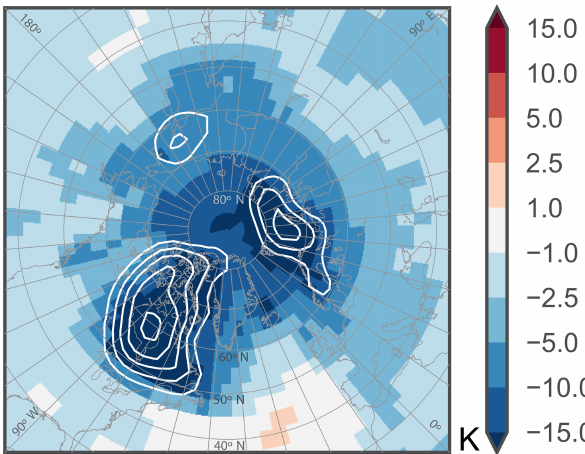
Figure 3. Temperature difference between the pre-surge phase and a preindustrial experiment, overlay: topography increase from preindustrial to pre-surge glacial state (mostly ice sheets) as seen by ECHAM5 at multiples of 500m. For a definition of the pre-surge phase see Fig. 1 and Sect. 2.3. Polar stereographic projection with grid lines at multiples of 10 ◦